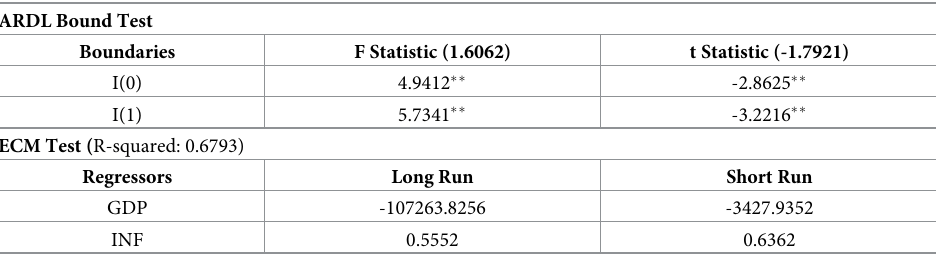
Table 2. Results of ARDL bound test and